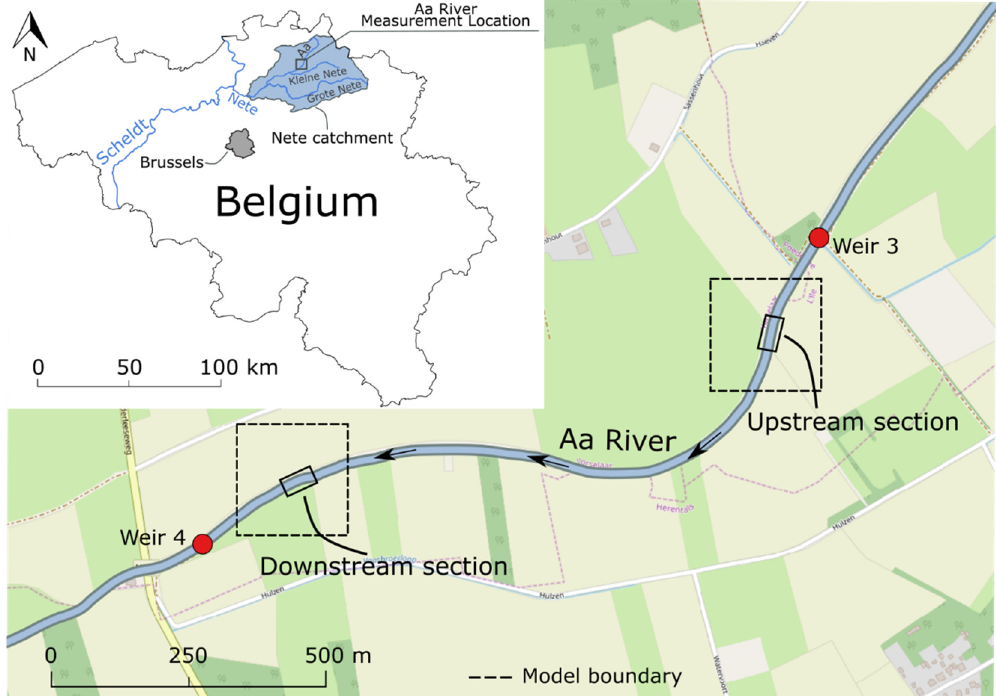
Figure 1. Map of Belgium showing the Nete River catchment and its main rivers in blue (upper left). The study site is located along the lower reaches of the Aa River. The studied downstream and upstream sections are outlined, with dashed lines indicating the boundaries of fine-scale groundwater models (MODFLOW).